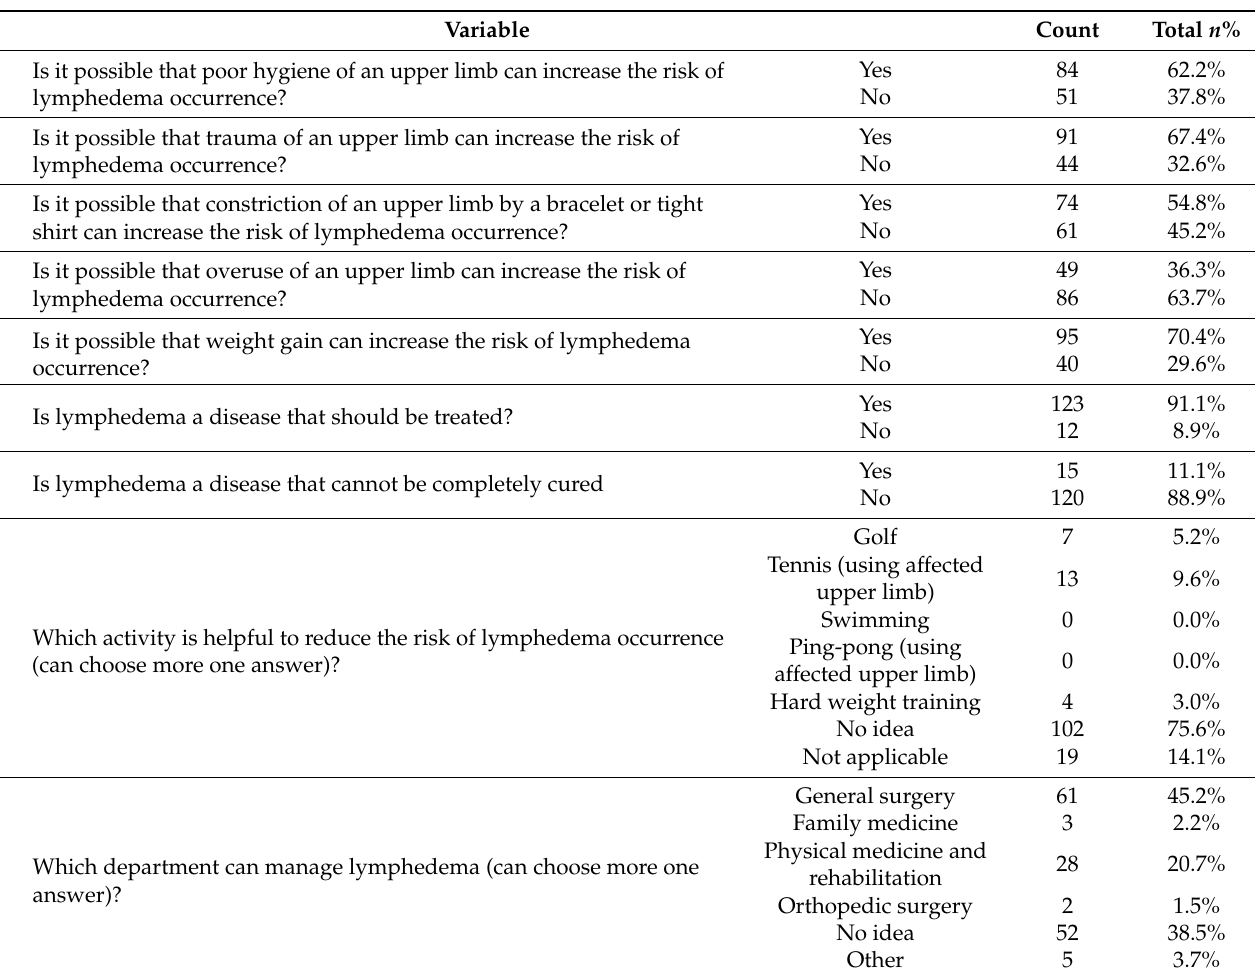
Table 4. Percentage and frequency for the study sample by their BCRL level of awareness of risk factors and management ( n =